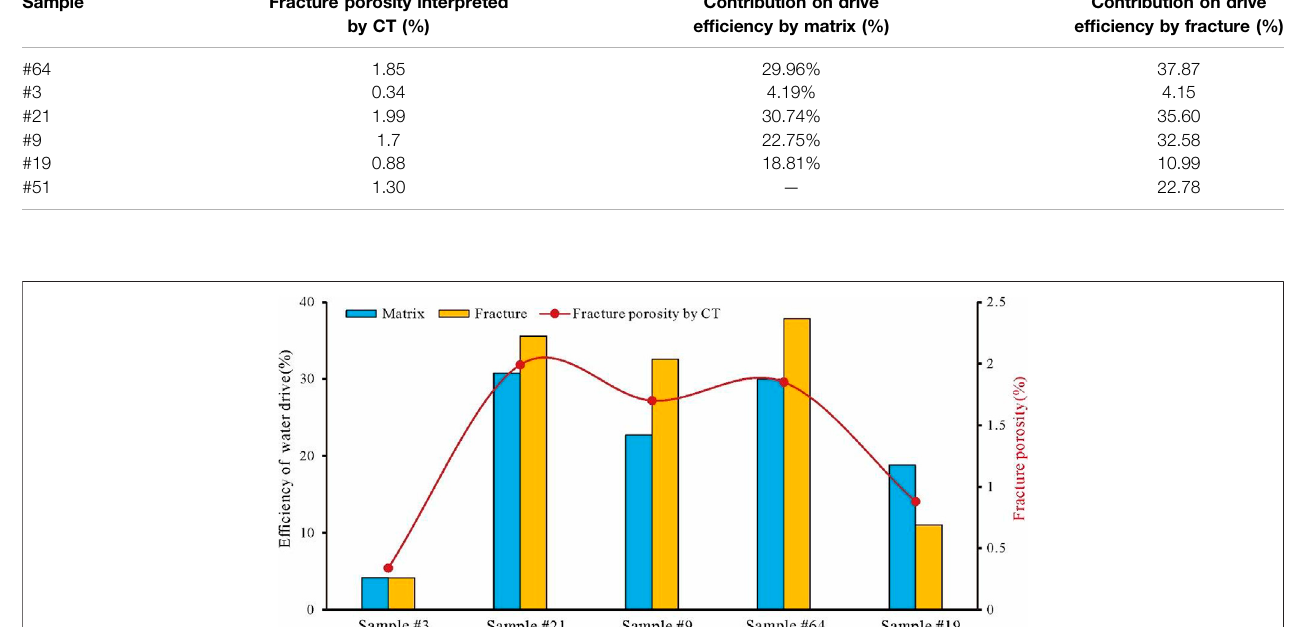
FIGURE 17 | Fracture porosity by CT and contribution of the drive ef fi ciency by the matrix and fracture.